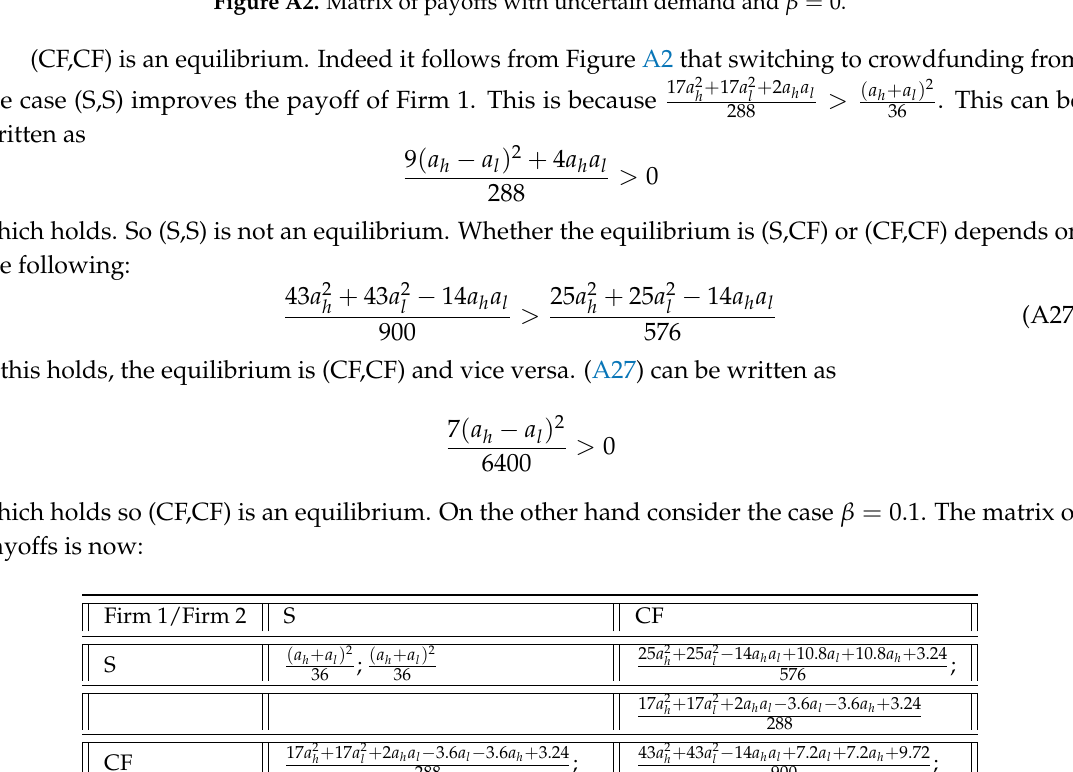
Figure A2. Matrix of payoffs with uncertain demand and β = 0.